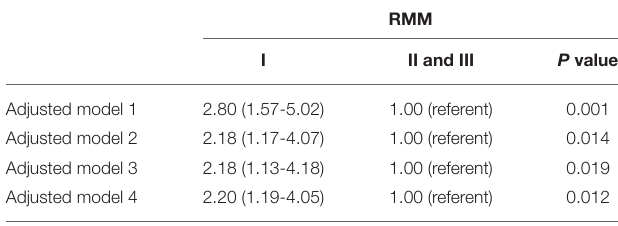
TABLE 4B | Adjusted odds ratio (95% CI) of the lowest tertile of ASM/weight index for NAFLD.